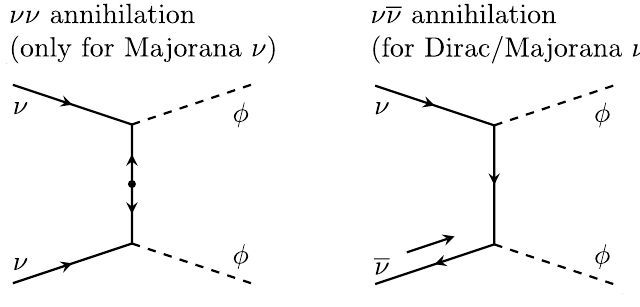
Figure 8 . Majorana and Dirac neutrino